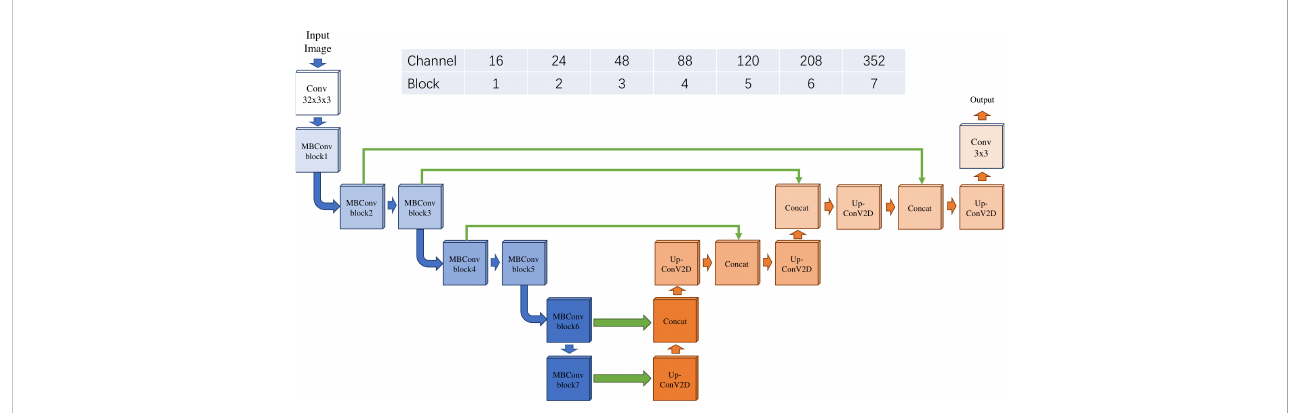
FIGURE 2 The architecture of Eff-Unet with Ef fi cientNet B2 as the